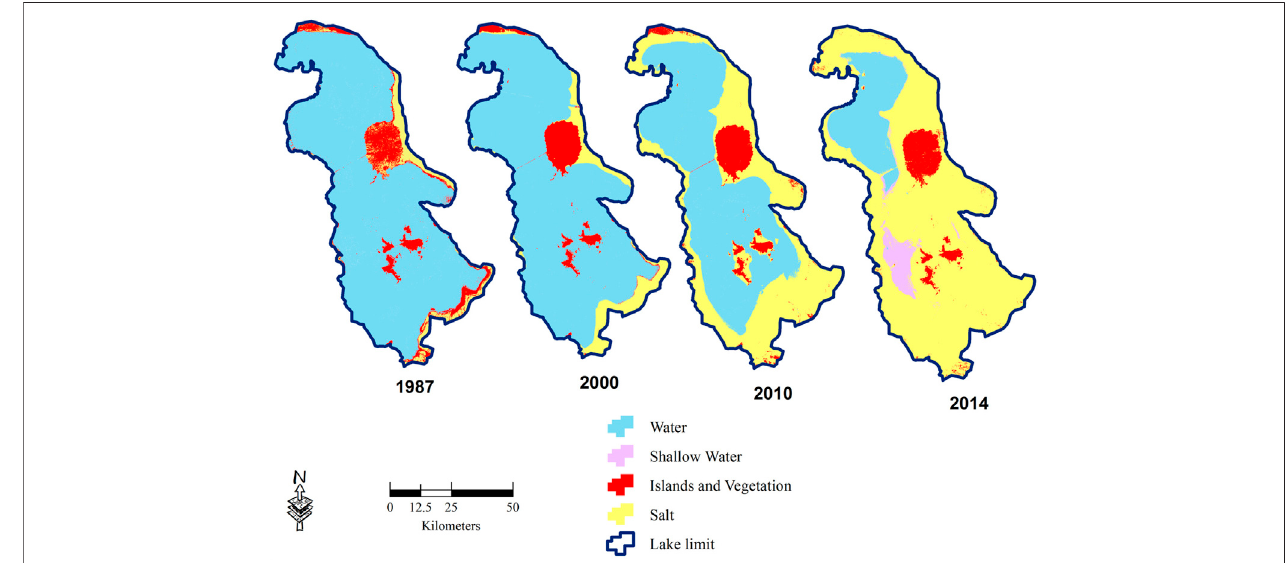
FIGURE 3 | Land-use class changing from 1987 to 2014 (author ’ s illustration).